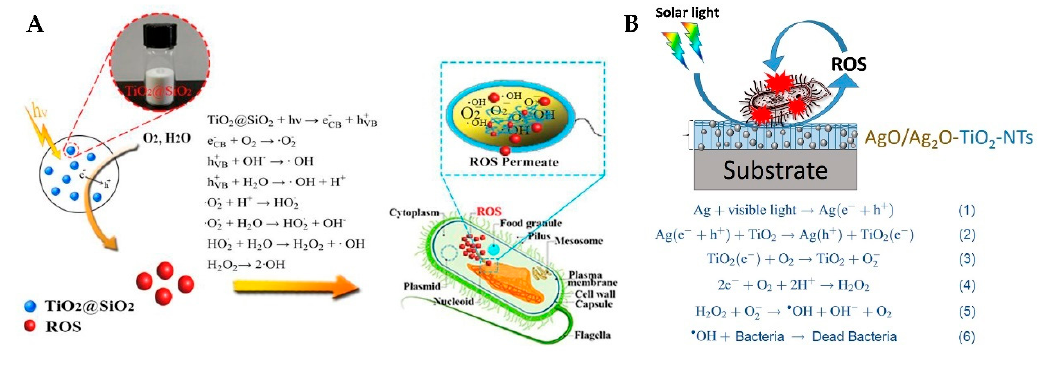
Figure 10. Schematic of photocatalytic antimicrobial mechanism of TiO 2 @SiO 2 hybrid materials and bacterial inactivation on Ag decorated TiO2-NTs [50,111].